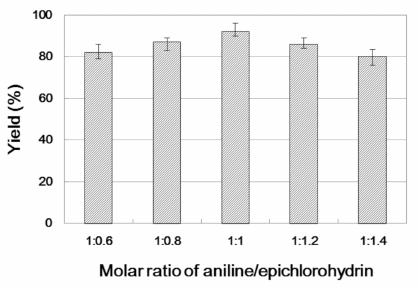
Figure 4. The influence of substrate ratio on the enzymatic synthesis of β -amino alcohol 3a under continuous-flow conditions.